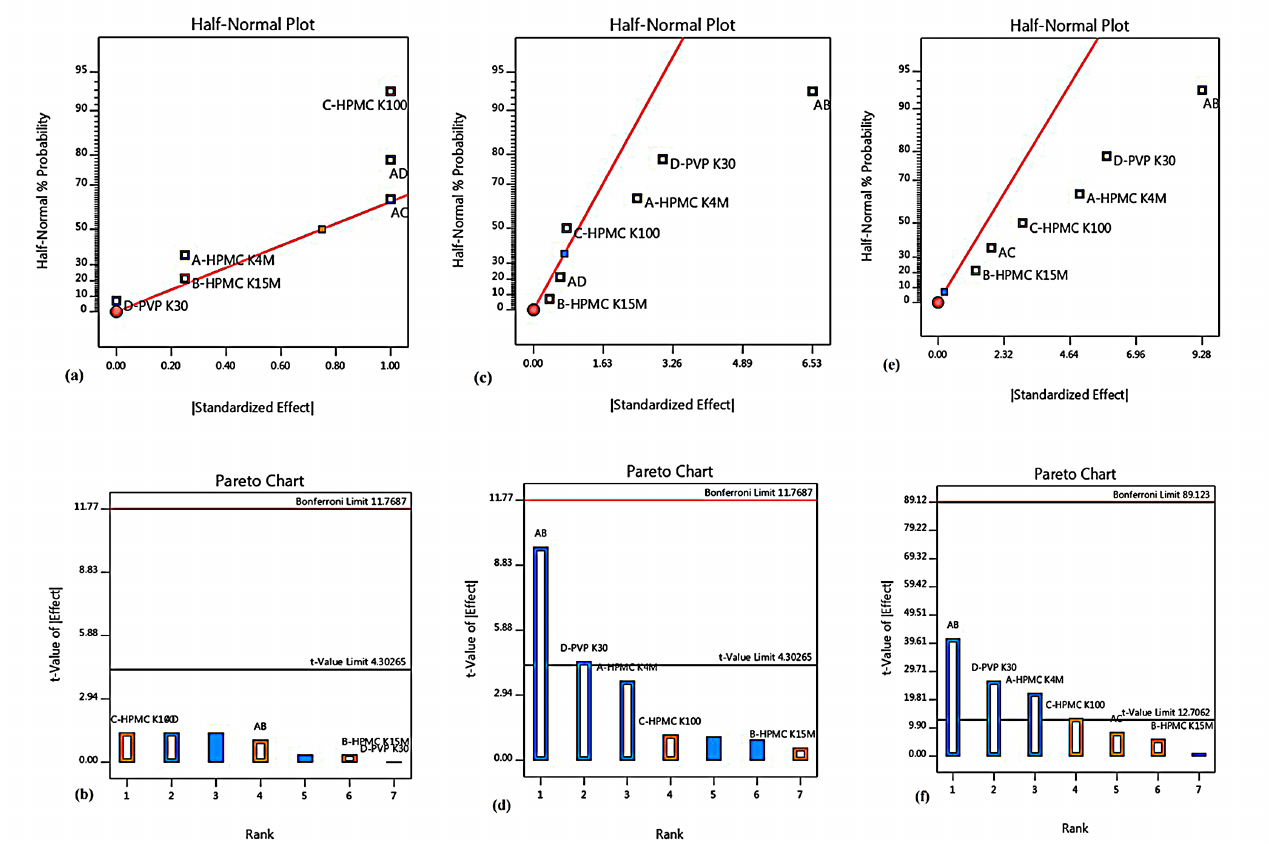
FIGURE 1 - (a) Half-normal plot for “response-1” with influence by factors considered in screening design, (b) Pareto chart for “response-1” with influence by factors considered in screening design, (c) Half-normal plot for “response-2” with influence by factors considered in screening design, (d) Pareto chart for “response-2” with influence by factors considered in screening design, (e) Half-normal plot for “response-3” with influence by factors considered in screening design, (f) Pareto chart for “response-3” with influence by factors considered in screening